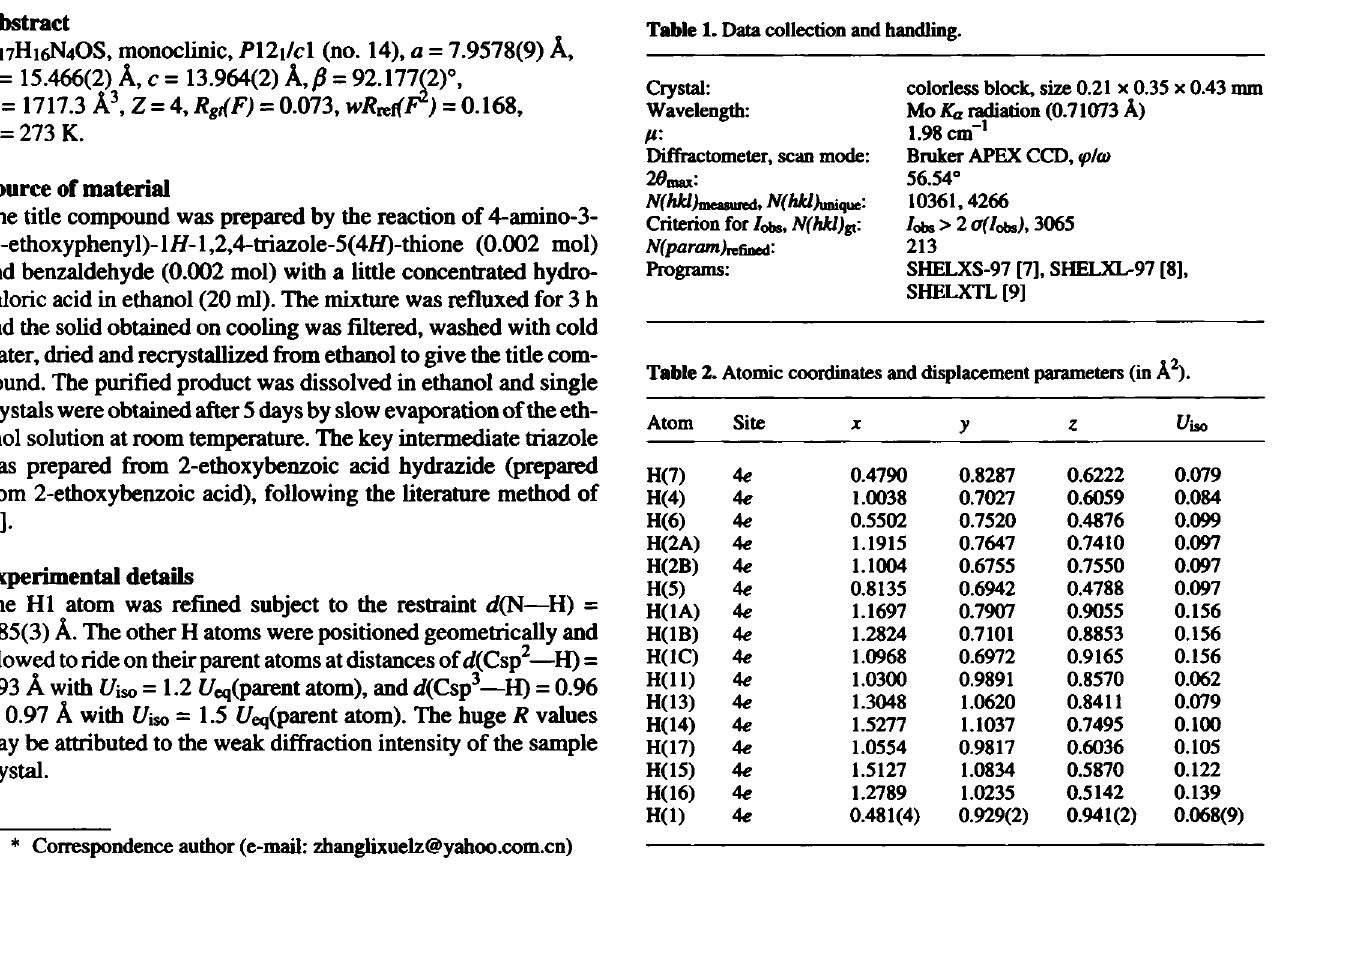
Table 1. Data collection and handling.